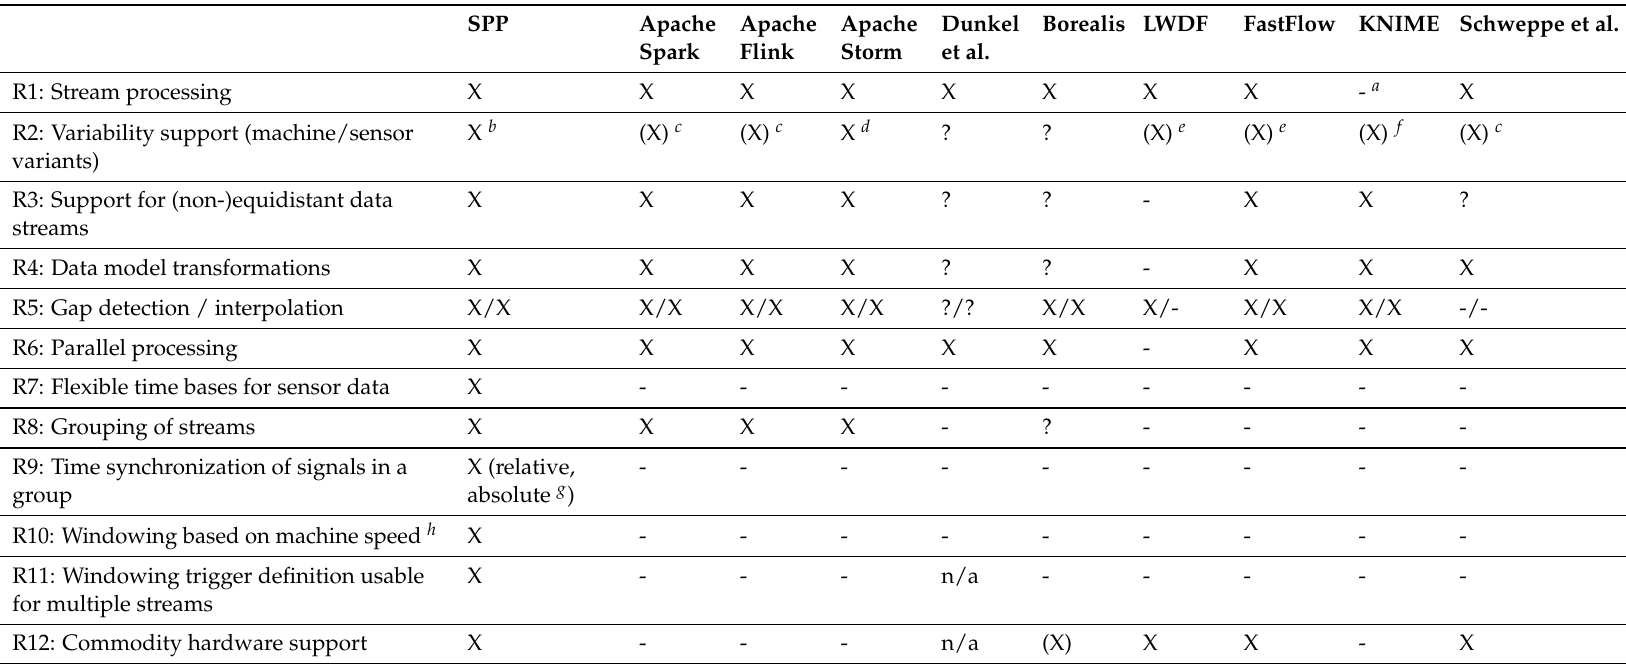
Table 1. Sensor data processing